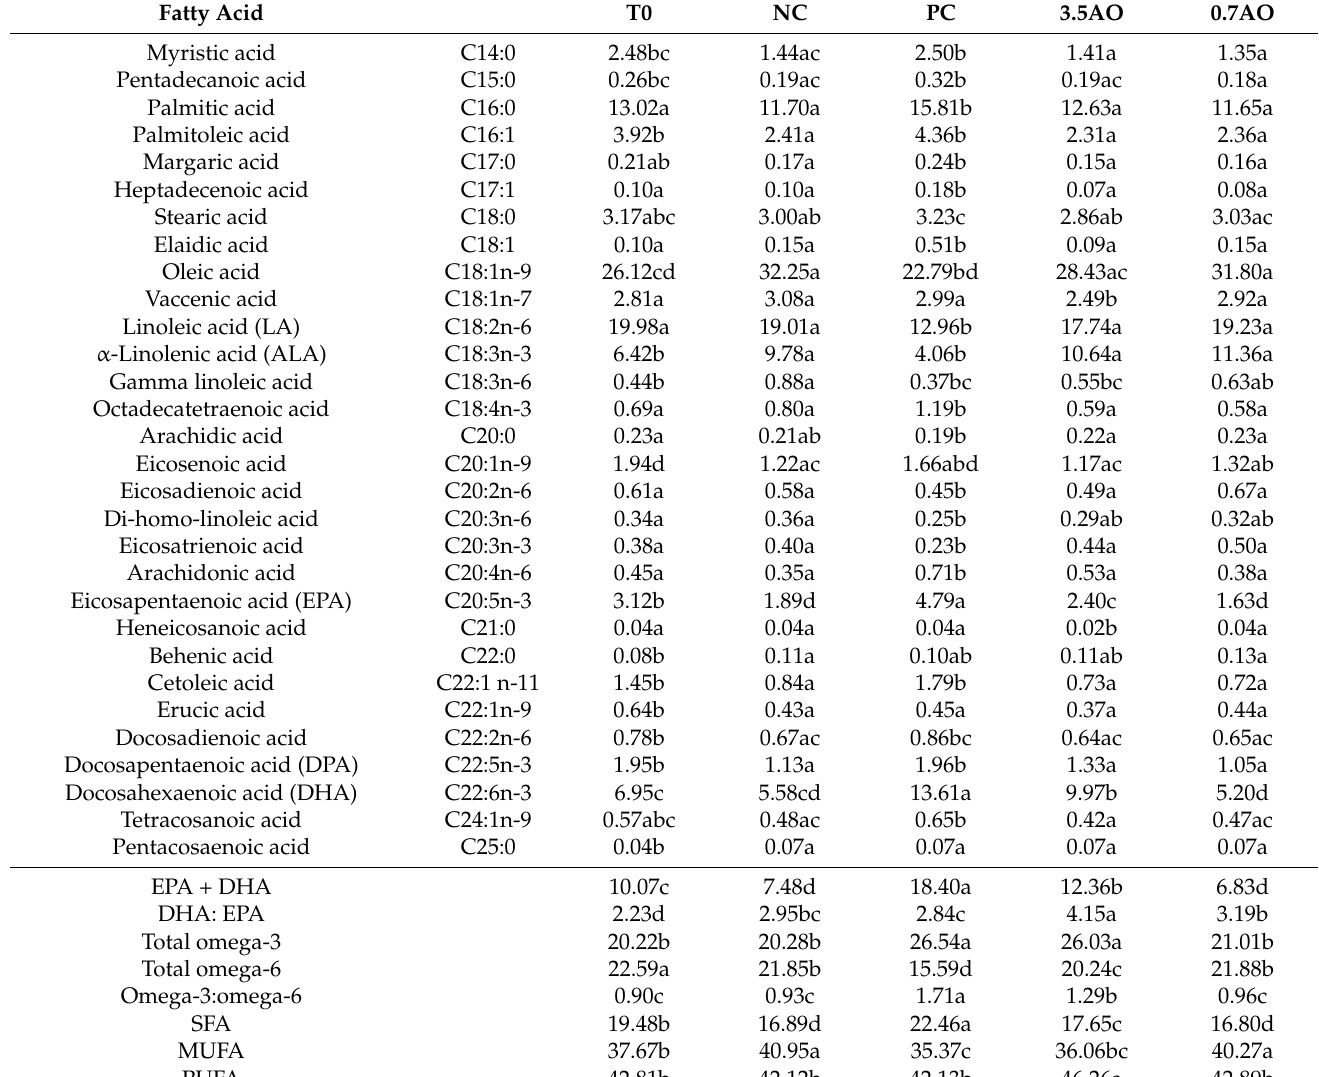
Table 3. Analysed fatty acid (g/100 g) composition of gilthead seabream flesh at the beginning of the trial (TO) and after 110 days of experimental feeding with the different experimental